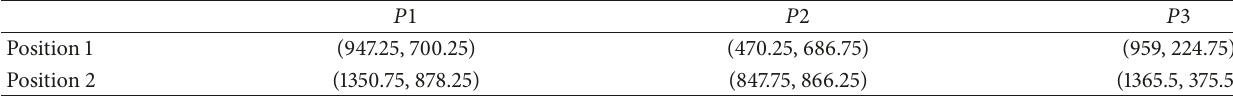
Table 3: Data before direction calibration.